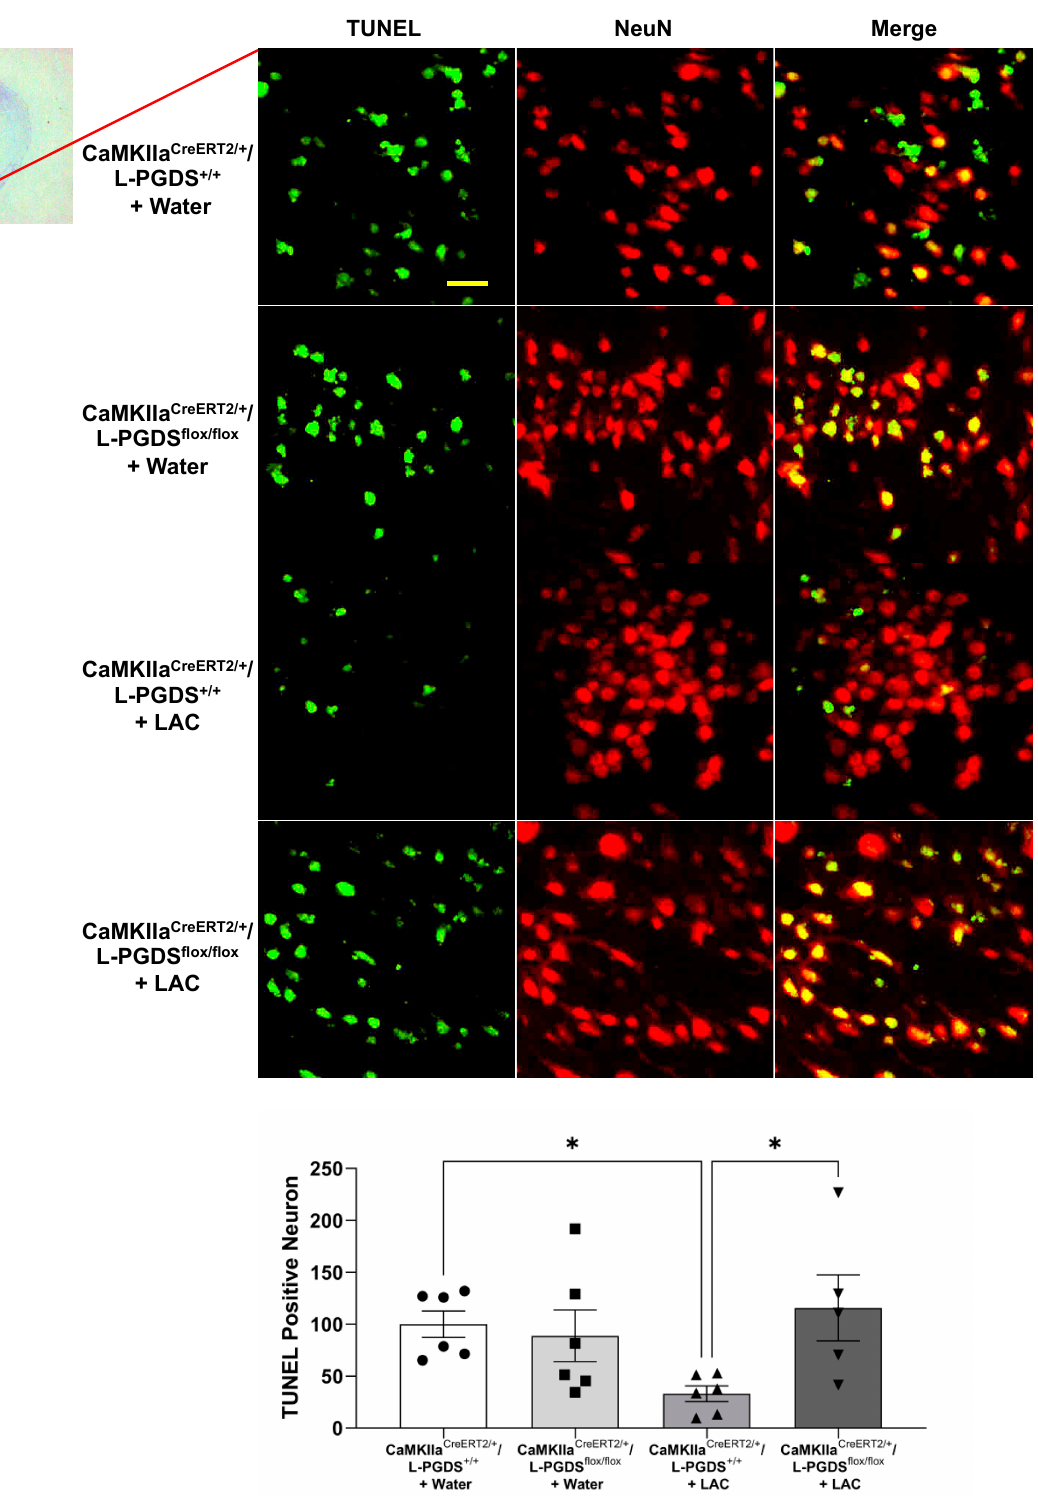
Figure 5. Effect of forebrain neuron-specific L-PGDS knockdown on TUNEL-positive neurons in the cerebral cortex following transient focal cerebral ischemia. ( A ) Representative double staining of NeuN and TUNEL in the peri-infarct cortex of the temporal lobe at the section 0.23 mm caudal to bregma. Scale bar = 20 μ m. ( B ) Values of TUNEL-positive neurons are means ± SEM for 5–6 mice in each group. * p < 0.05. Analyzed using two-way ANOVA followed by Tukey’s test.